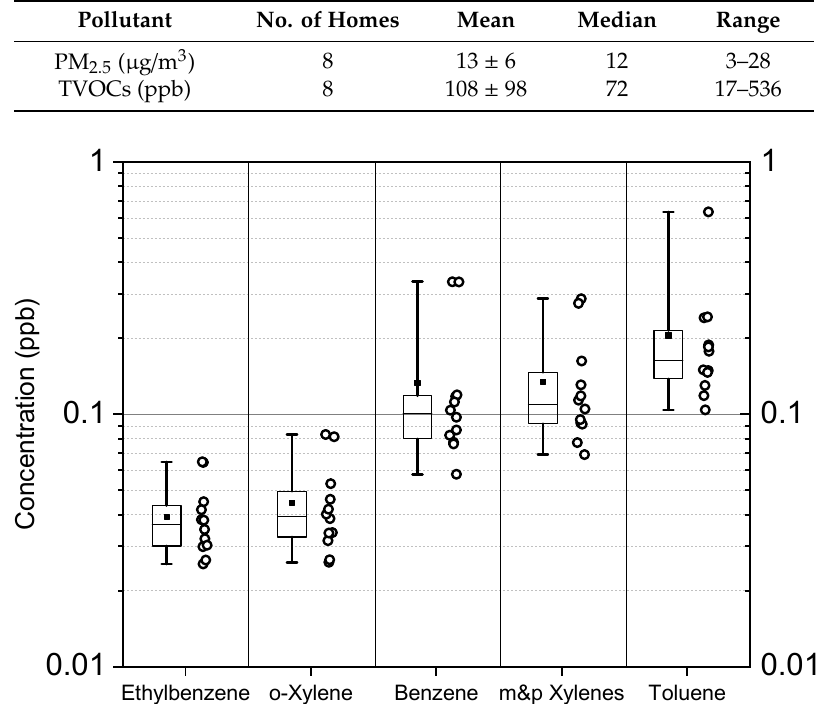
Table 2. Summary statistics for residential outdoor levels of fine particulate matter (PM 2.5 ) and total volatile organic compounds (TVOCs) measured in Deer Park, TX, between 27 April 2019 and 12 June 2019.